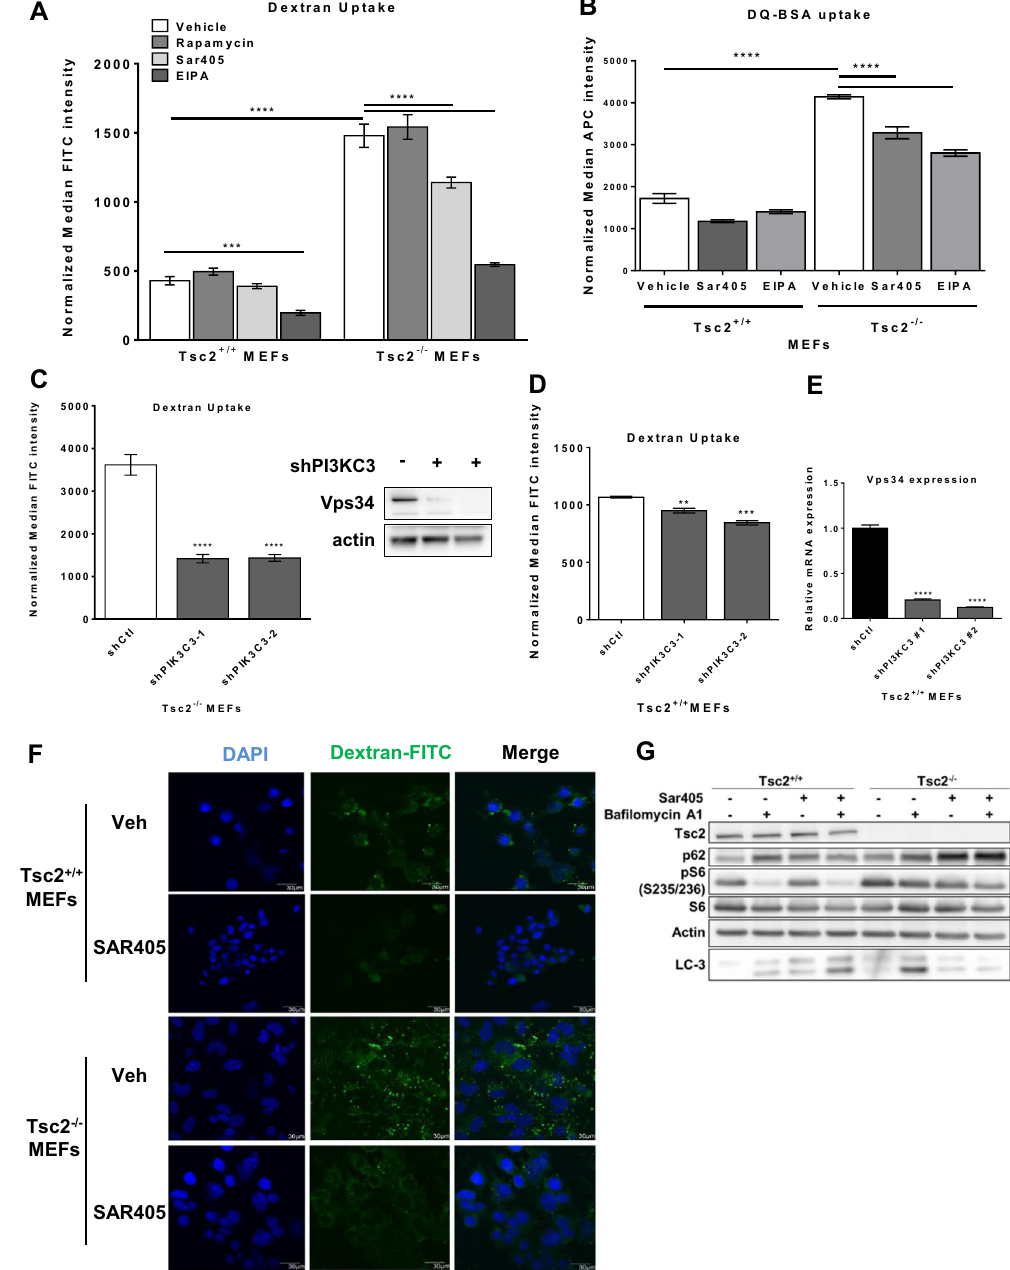
Figure 3. Enhanced macropinocytosis in Tsc2-deficient cells is Vps34-dependent. ( A ) Vps34 inhibitor SAR405 (2 uM, 24 hours) and the macropinocytosis inhibitor EIPA (25 uM, 24 hours) decreased macropinocytosis in Tsc2 − / − MEFs. Rapamycin (20 nM, 24 hours) had no effect on dextran uptake. ( B ) Uptake and lysosomal processing of exogenous albumin is enhanced in Tsc2-deficient cells. SAR405 (2 uM, 24 hours) and EIPA (25 uM, 24 hours) decreased uptake of macropinocytic cargo DQ-BSA. ( C ) Vps34 downregulation in Tsc2 − / − MEFs reduced uptake of dextran. The blot was cropped to highlight the relevant bands. The full-length blot is presented in Supplementary Figure 4. ( D ) Vps34 downregulation in Tsc2 + / + MEFs had no effect on dextran uptake. ( E ) Quantitative real-time PCR validation of Vps34 knockdown. ( F ) Confocal microscopy revealed reduced FITC-Dextran positive macropinosomes in Tsc2 − / − MEFs treated with SAR405 (2 uM, 24